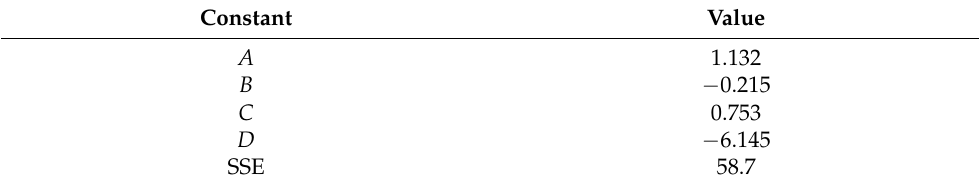
Figure 9. Parity plot of calculated PM vs. measured PM for the two-pad data using Equation (6). Table 2. Curve-fit constants for correlation of two-pad PM data (Equation (6)).